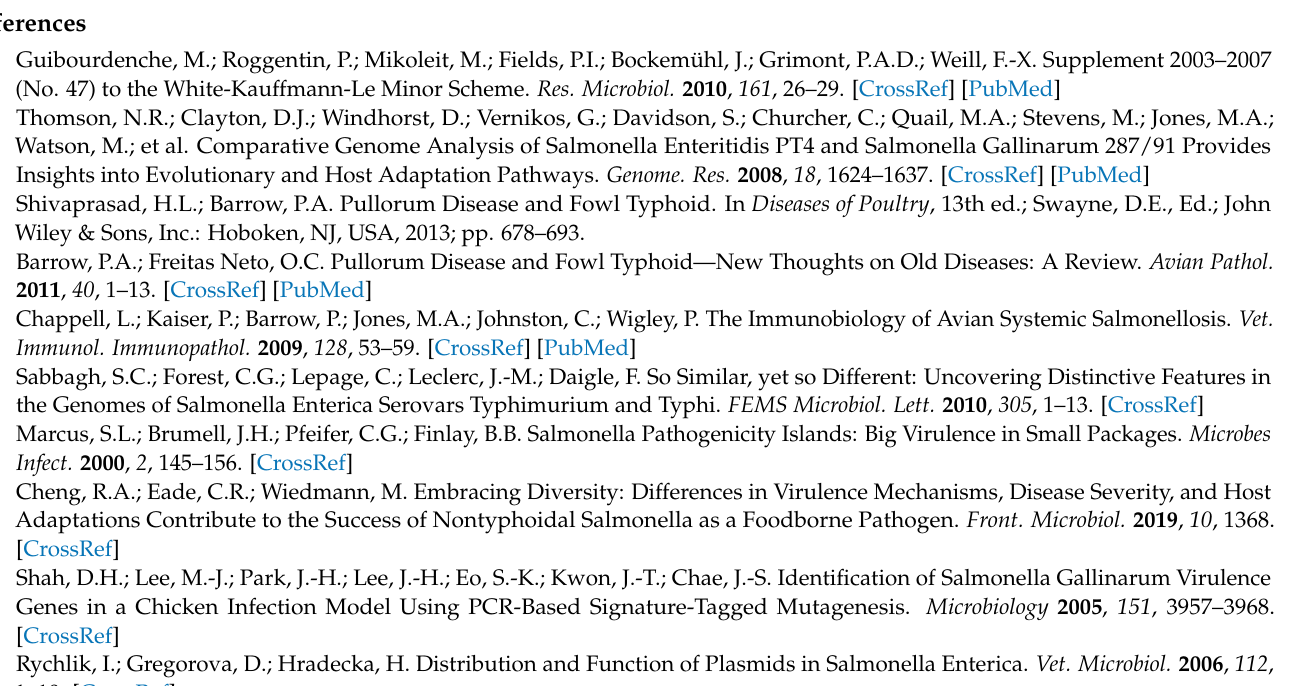
indicated. Table S3: Virulence factors. The indicated values represent the percentage of coverage of identified genes in accordance with the VFDB. Table S4: Prophages sequences identified by Phaster search tool. Features such as localization, length, completeness, score, number of proteins, most common phage, and GC% are